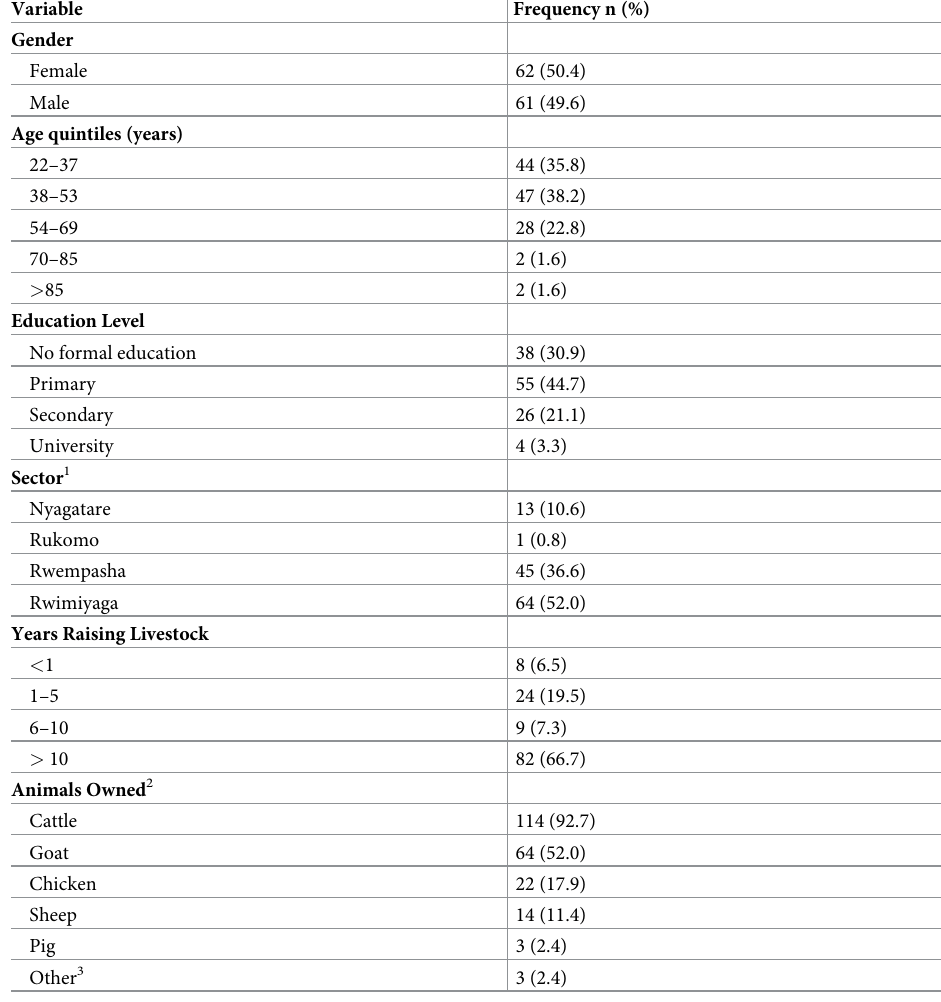
Table 2. Demographic profile of respondents from Nyagatare District, Rwanda (N =